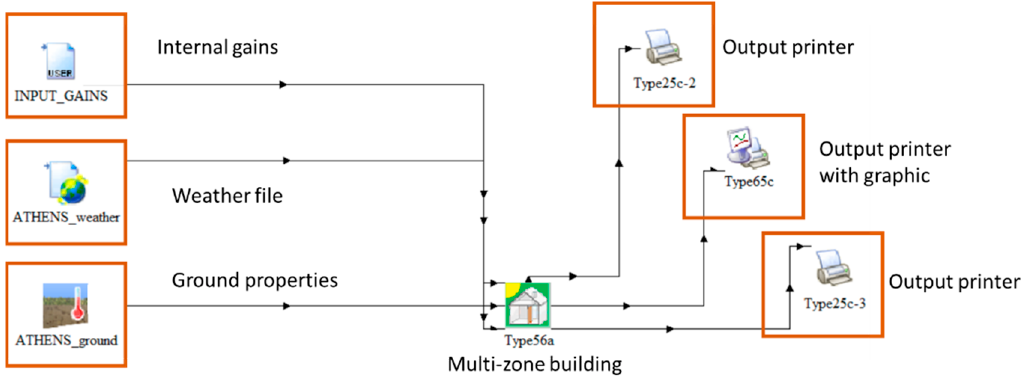
Figure 2. Model in TRNSYS simulation environment.